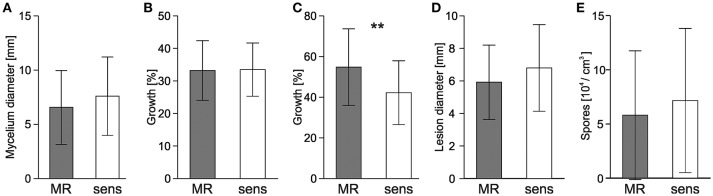
Growth and infection behavior of B. cinerea MR and sensitive field strains. Mean values of 19 MR isolates and 20 sensitive isolates are shown. (A) Radial growth on malt extract medium. (B,C) Inhibition of radial growth in the presence of 1 M NaCl (B) or 10 mM H2O2
(C). (D) Lesion development on detached tomato leaves. (E) Sporulation efficiency on malt extract agar. Growth and infection assays (A–D) were evaluated after 72 h, sporulation after 14 d. Significant differences at **p < 0.01 are indicated.